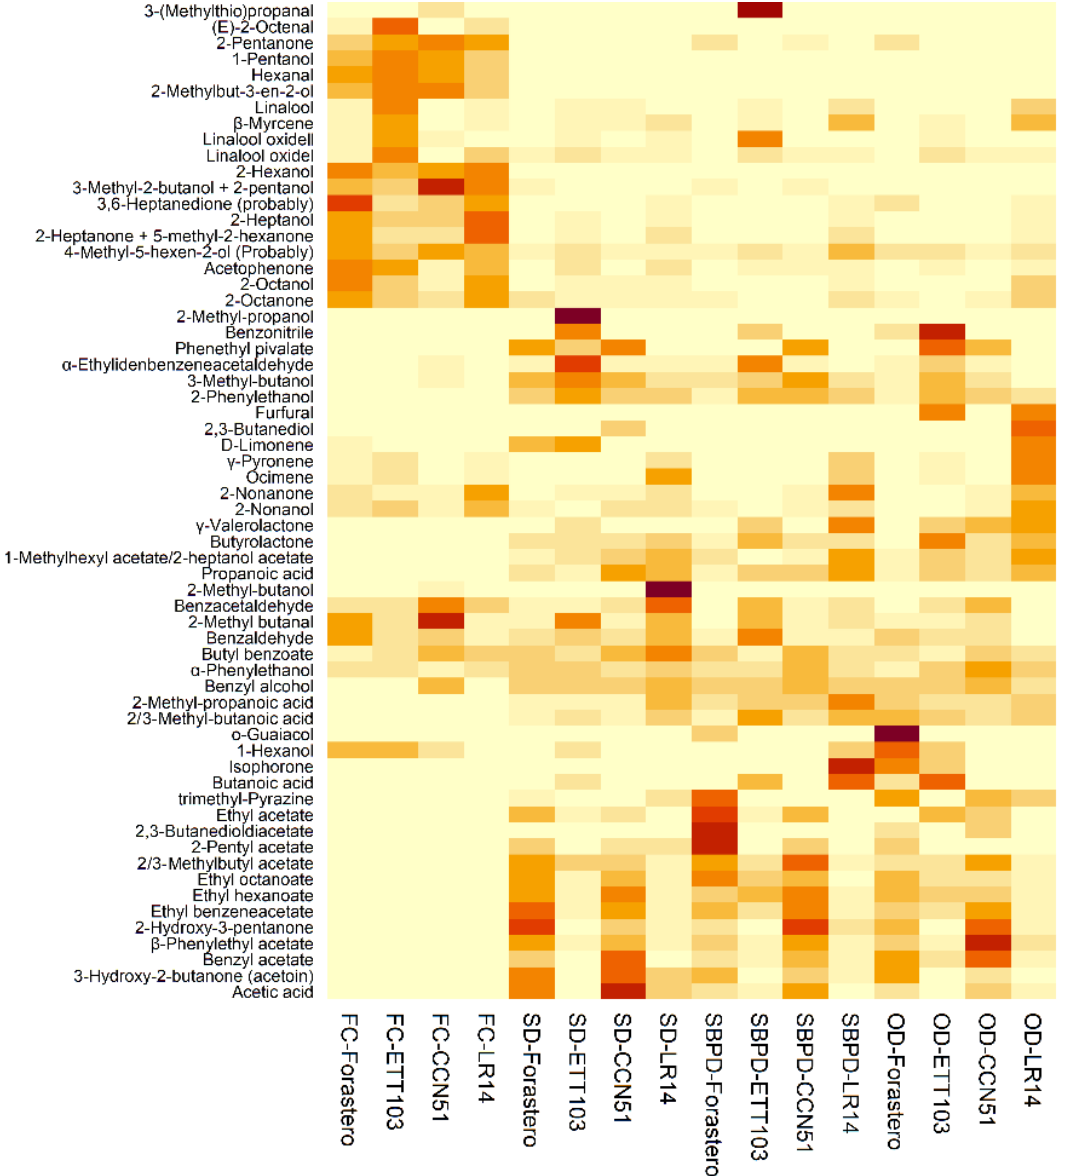
Figure 1. Hierarchical cluster analysis heatmap constructed using normalized areas from volatiles identified in bulk (Forastero and CCN51) and fine-flavor (ETT103 and LR14) cocoa in the fresh state or after drying using the sun drying (SD), sun black plastic sheeting drying (SBPD), and oven drying (OD) techniques.